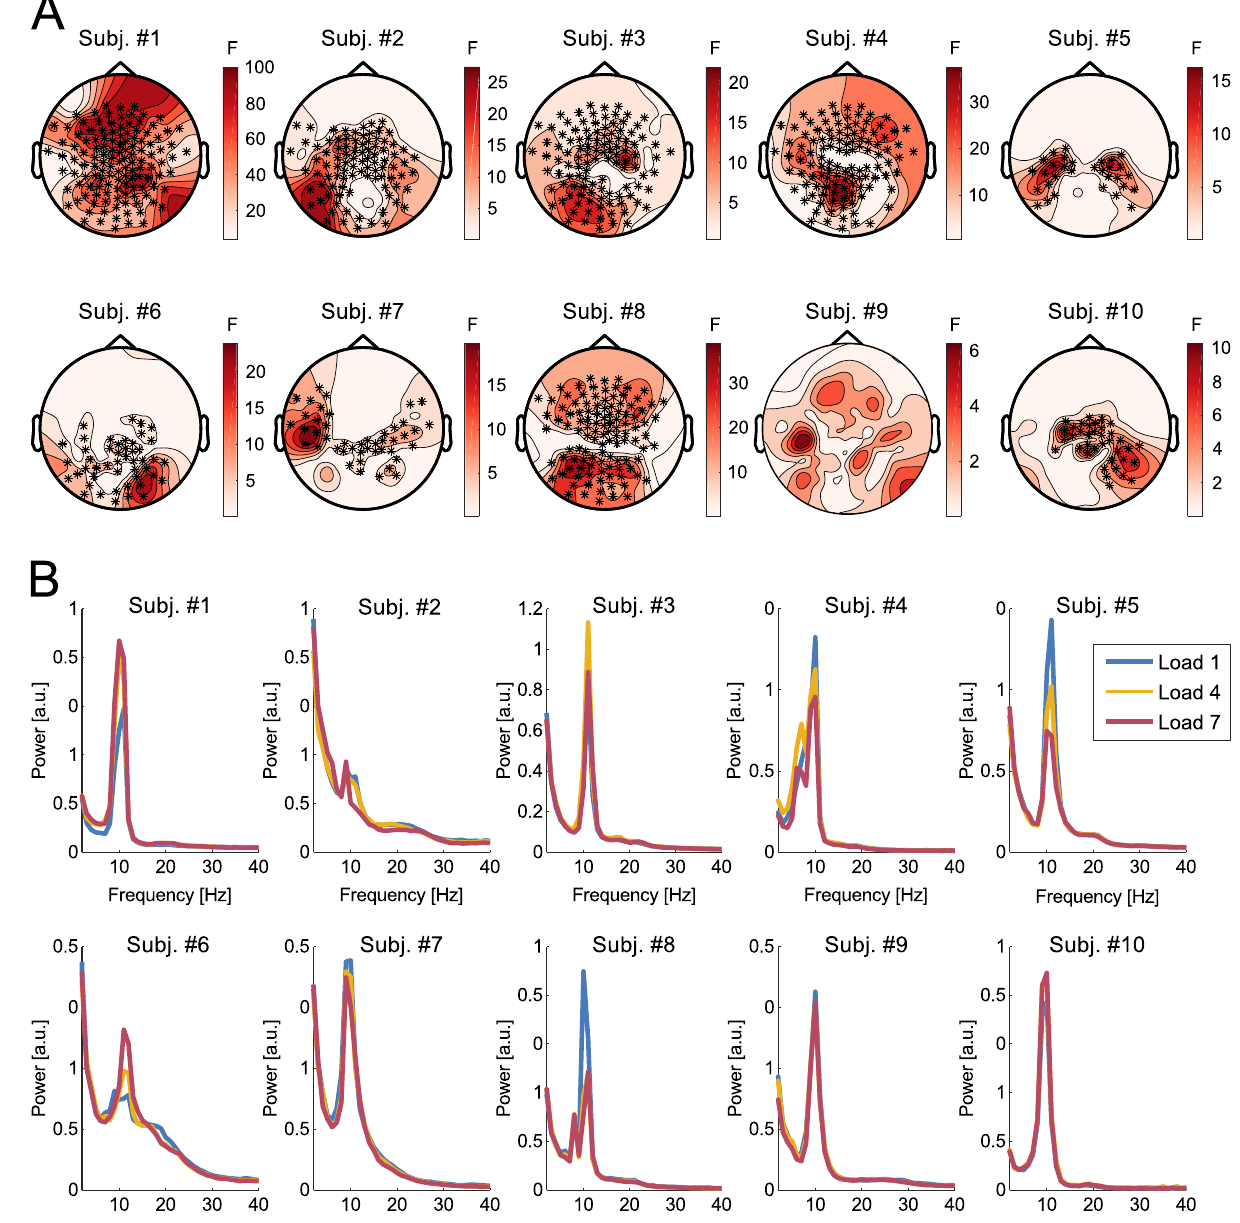
Fig 4. Cluster-based inferential statistics. (A) Topography of the main effect of working memory load illustrated for each individual participant. Warm colors indicate the spatial distribution of F-values. Asterisks denote electrodes corresponding to clusters on the basis of which the null hypothesis is rejected. (B) Power spectra averaged across the electrodes belonging to the corresponding clusters illustrated in A in arbitrary units (a.u.). Note that scales are plotted on an individual level, as condition differences within participants are of primary